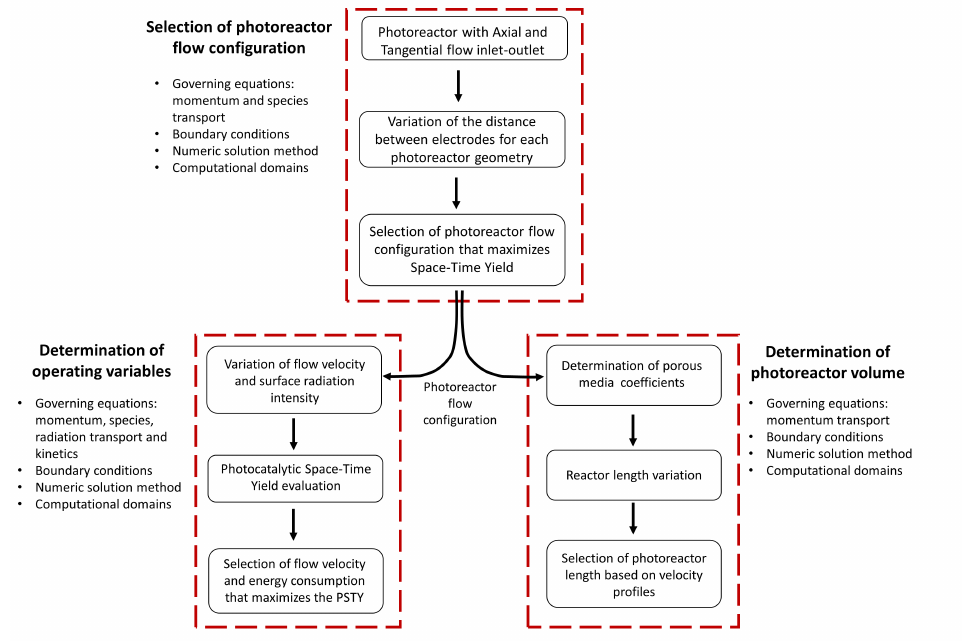
Figure 2. Procedure to select the photoreactor geometry and the operating